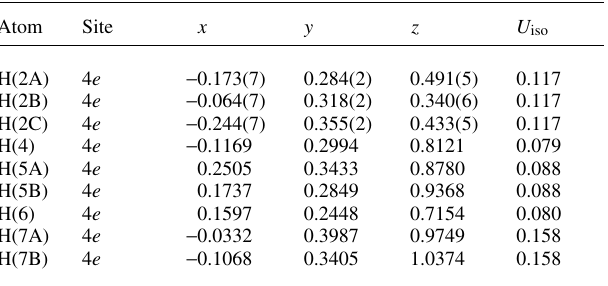
Table 2. Atomic coordinates and displacement parameters (in Å 2 )